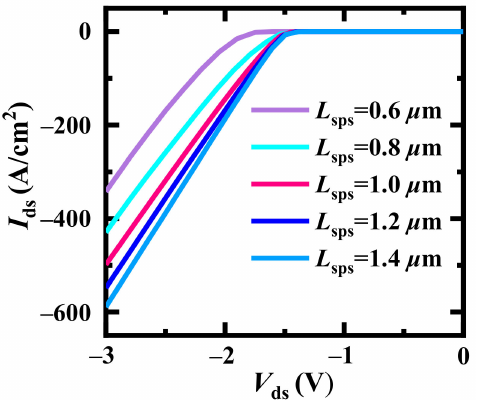
Figure 5. Third quadrant characteristics of FS-TMOS dependent on L sps . The distribution of current density and the current flowing path inside the FS-TMOS at forward and reverse conductive state (i.e., C1 and C2 point of Figure 6) are depicted in the insets of Figure 5. The reverse current flowing through Schottky contact when I ds is 100 A/cm 2 indicates the desirable inactivation of P body/N drift formed diode in reverse conduction operation. The V on of FS-TMOS is reduced to 1.5